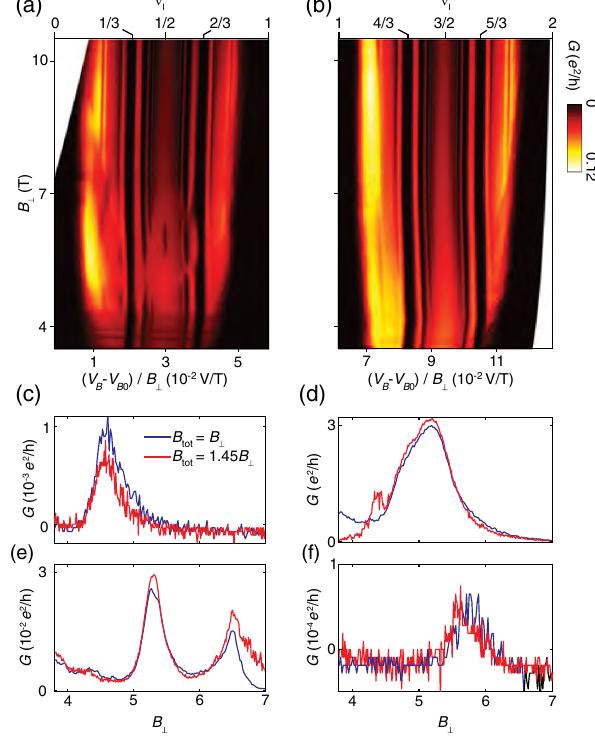
FIG. 2. Signature of isospin phase transition in charge transport measurement. (a) Interisland conductance as function of B ⊥ and V showing fractional quantum Hall isospin transitions in the B < 1 . range corresponding to Landau level filling factors 0 < ν I The x axis is offset and scaled by the applied magnetic field so that it is approximately proportional to ν . (b) Same as (a), measured I < 2 . Isospin phase transitions are absent in this between 1 < ν I 1 = 3 . The maximum in G regime. (c) Blue: line cut of (a) at ν I ¼ indicates the isospin phase transition. Red: same as the blue trace, measured with a tilted magnetic field applied. The tilting angle is 1 . 45 B fixed so that the total magnetic field B ⊥ . (d) Same as tot ¼ 2 = 5 . (e) Same as (c),(d), measured at (c), measured at ν I ¼ ν 3 = 5 . (f) Same as (c) – (e), measured at ν 2 = 3 I ¼ I ¼